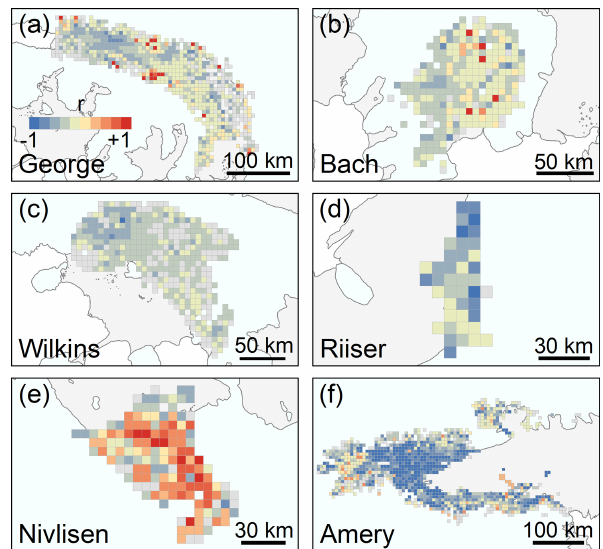
Figure 9. Pixel-based correlations ( r ) between January fractional lake extents and previous-year precipitation over George VI, Bach, Wilkins, Riiser-Larsen, Nivlisen and Amery ice shelves. Due to the low number of observations, also correlations with p > 0 . 05 are shown. The coastline and grounding line (grey) data are from Mouginot et al. (2017) and Rignot et al. (2013).